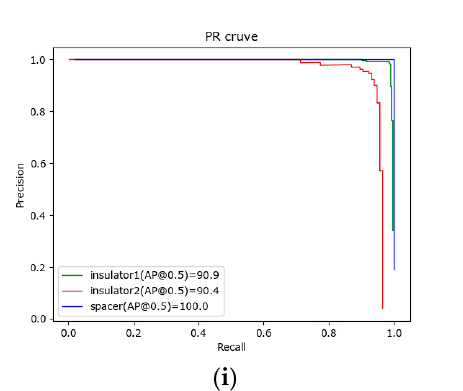
Figure 12. Performance comparison of different detectors: ( a ) faster R-CNN; ( b ) R-FCN; ( c ) SSD_vgg; ( d ) SSD_resnet; ( e ) SSD_mobilenet; ( f ) SSDLite_mobile; ( g ) SSDLite_mnas; ( h ) Ours1; ( i ) Ours2.